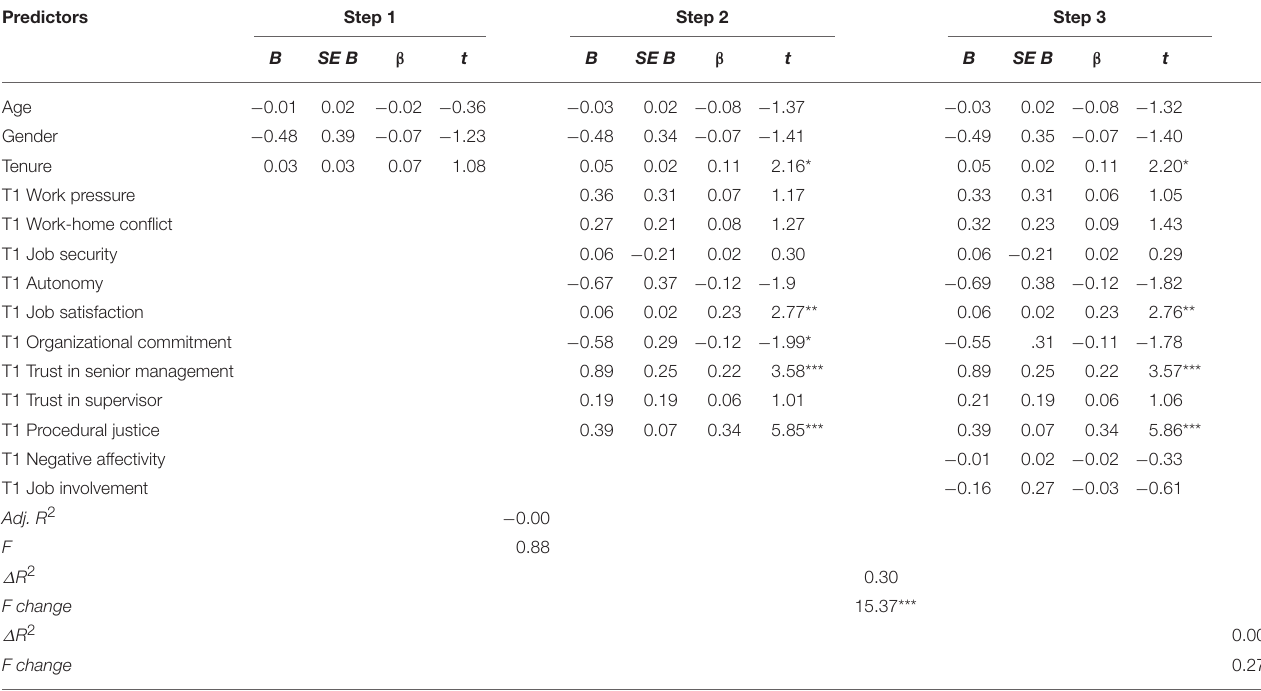
TABLE 5 | Multiple regression analyses of all predictors of T2 procedural justice for the non-academic (professional) staff category.